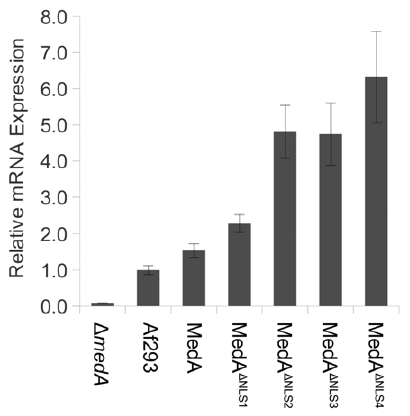
Figure 6. Relative gene expression of cytoplasmic and nuclear medA measured by RT-PCR. Af293 is the A. fumigatus wild type strain; MedA, MedA D NLS1 , MedA D NLS2 , MedA D NLS3 , and MedA D NLS4 indicate expression of the corresponding construct under the control of the medA(p) in the D medA strain, normalized to medA expression in strain Af293. Error bars represent the standard error of three triplicates for every strain.